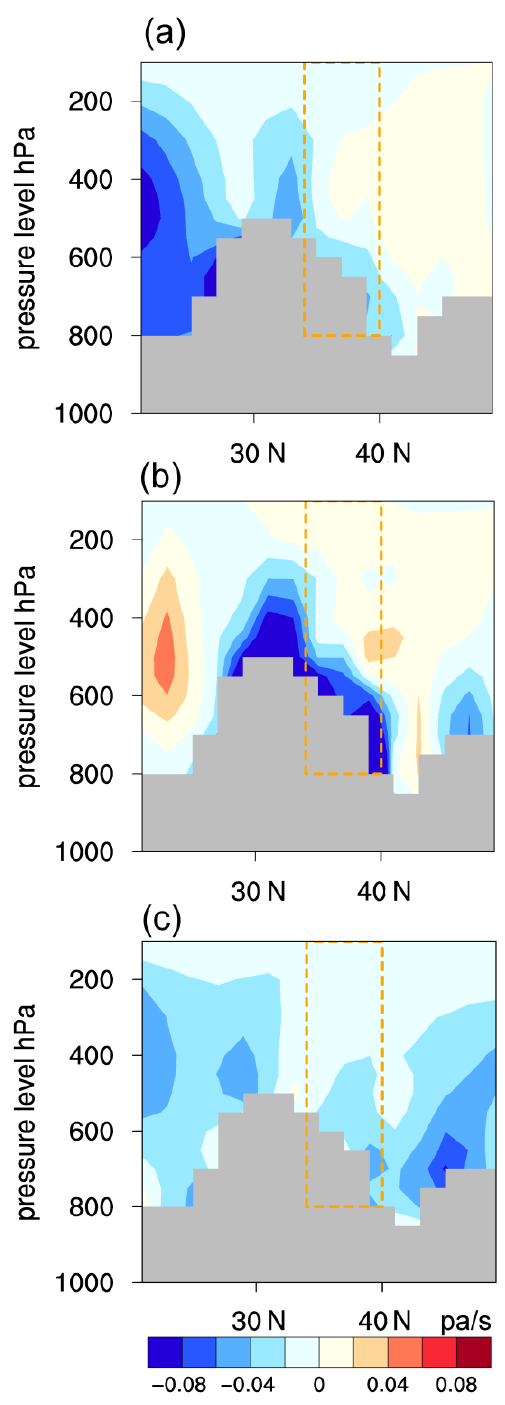
Figure 5. Latitude–pressure cross sections averaged over meridional belt of 97–103 ◦ E for: ( a ) composite Figure 5. Latitude – pressure cross sections averaged over meridional belt of 97 – 103° E for: ( a ) composite 226 vertical velocity mean during June–October (2010–2015), ( b ) composite vertical velocity di ff erence vertical velocity mean during June – October (2010 – 2015), ( b ) composite vertical velocity difference 227 (nighttime (20:00) minus daytime (08:00)) during June–October (2010–2015), and ( c ) composite vertical (nighttime (20:00) minus daytime (08:00)) during June – October (2010 – 2015), and ( c ) composite vertical 228 velocity di ff erence before (70 days) and after (40 days) transition date during June–October (2010–2015). velocity difference before (70 days) and after (40 days) transition date during June – October (2010 – 2015). 229 Orange boxes indicate the study Orange boxes indicate the study region. 230